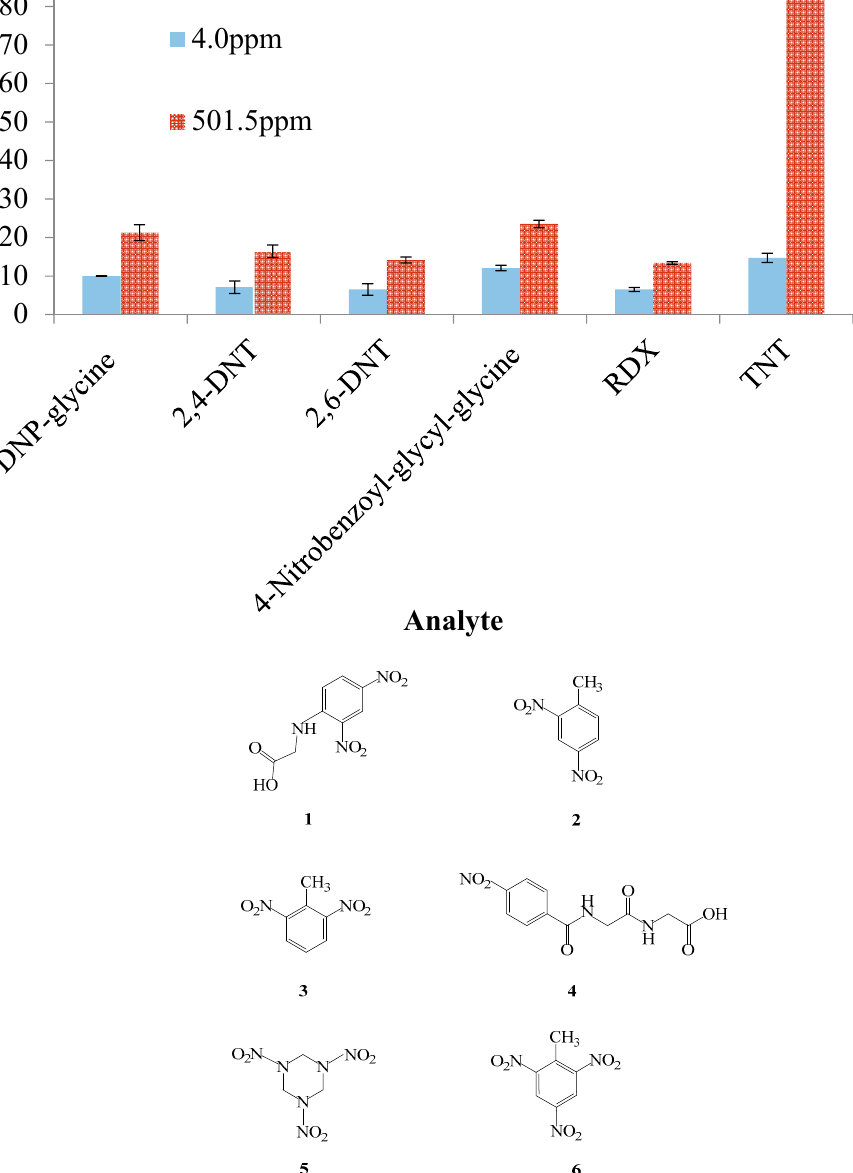
Figure 4. The response of TNTHCDR3 anchored SPR Au sensor chip towards 4.0 ppm ( blue ) and 501.5 ppm ( red ) solutions of 2,4-dinitrophenyl glycine (DNP-glycine) ( 1 ), 2,4-dinitrotoluene (2,4-DNT) ( 2 ), 2,6-DNT ( 3 ), 4-nitrobenzoyl-glycyl-glycine ( 4 ), research and development explosive (RDX) ( 5 ), and TNT ( 6 ). The error bar indicates the calculated standard deviation ( n = 3).